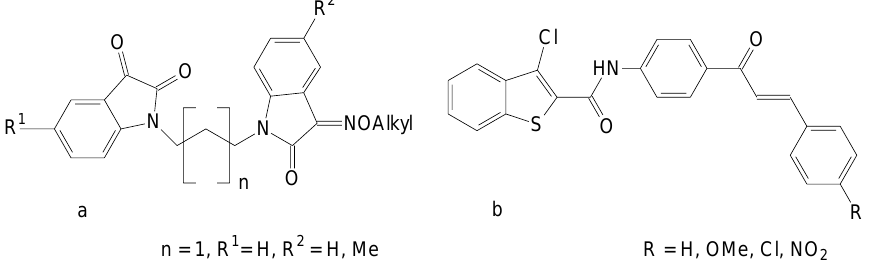
Figure 1. Structures of bisindoles with the indole scaffold ( a ) and the benzothiophenes with shown scaffold ( b ).